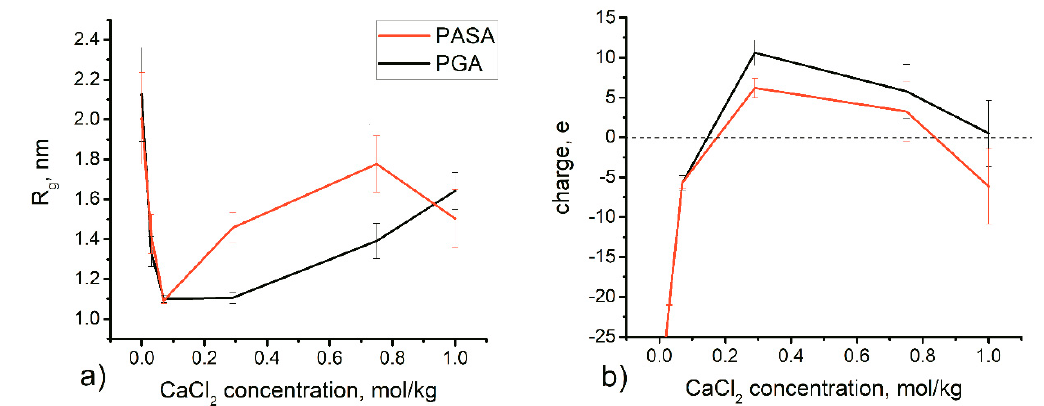
Figure 2. ( a ) Radius of gyration and ( b ) charge of the complex formed by the poly(amino acid) and adsorbed ions (both Ca 2 + and Cl − ) as a function of salt concentration. The horizontal dashed line corresponds to zero charge (exact charge neutralization).